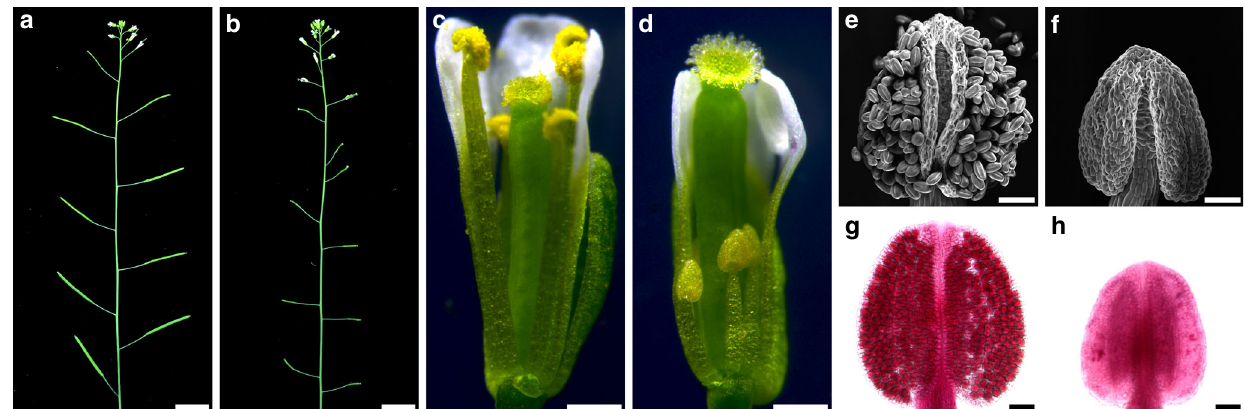
Fig. 1 A quintuple mutant, bes1-1 bzr1-1 beh1-1 beh3-1 beh4-1 ( qui-1 ), shows a male sterile phenotype due to shortened fi laments and pollenless anthers. a , b In fl orescences phenotypes of wild-type Col-0 ( a ) and qui-1 ( b ). Col-0 siliques are elongated and produce viable seeds, while mutant siliques fail to elongate and are devoid of any seeds. c , d Optical micrographs of Col-0 ( c ) and qui-1 ( d ) fl owers. qui-1 develops stamens with fi laments much shorter than Col-0. e – h Anthers of Col-0 ( e , g ) and qui-1 ( f , h ) visualized by a SEM microscope ( e , f ) and Alexander staining ( g , h ), respectively. Col-0 anthers give rise to viable pollen grains while mutant anthers are completely pollenless. Scale bars represent 1 cm in ( a ), ( b ), 0.5 mm in ( c ), ( d ), and 50 μ m in ( e –